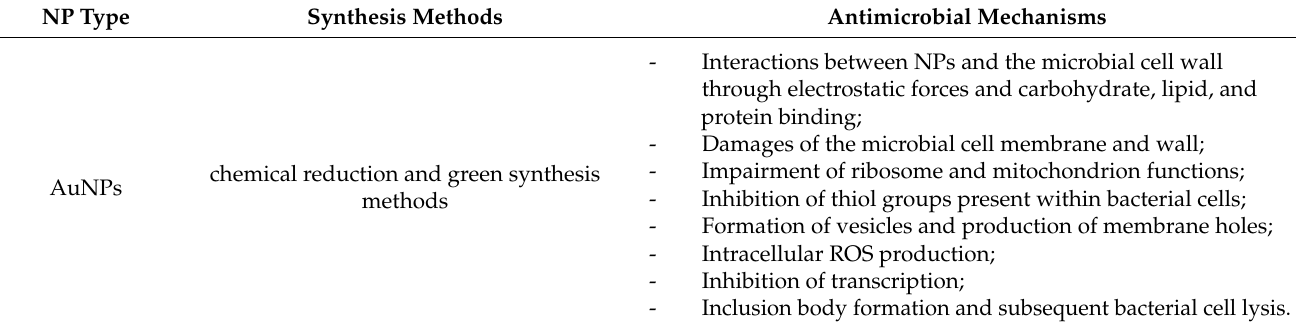
Table 1. Summary of the main synthesis methods and antimicrobial mechanisms for AuNPs, AgNPs, CuNPs, ZnO NPs, TiO 2 NPs, MgO NPs, and Fe 3 O 4 NPs.